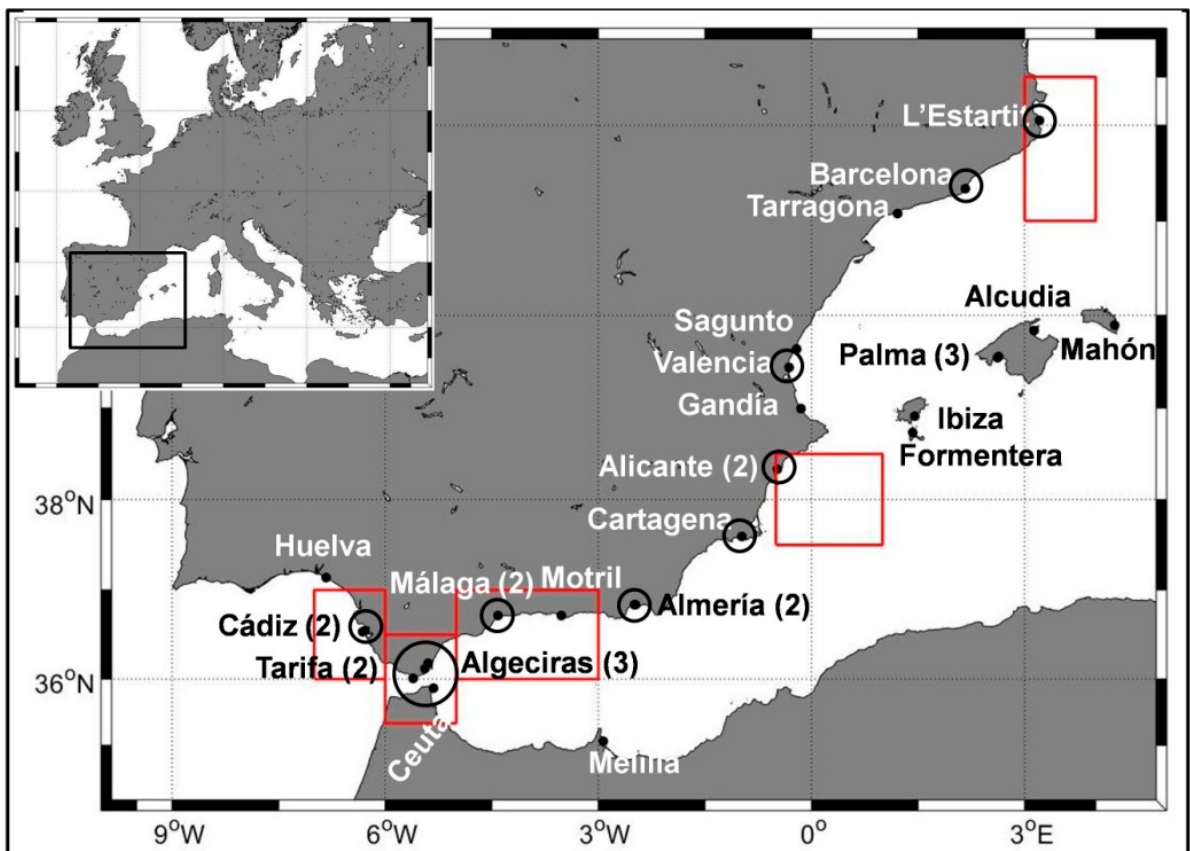
Figure 1. Position of the 31 tide gauges initially considered. Circles indicate the position of the long time series finally considered for the analysis, for filling gaps, or for validation of the reconstructed long time series. The number of tide gauges (operated by different institutions) at the same location are indicated in parenthesis. Red boxes are the areas selected for the collection of temperature and salinity profiles from the EN4 product (Met Office) and the NCAR/UCAR Research Data Archive.